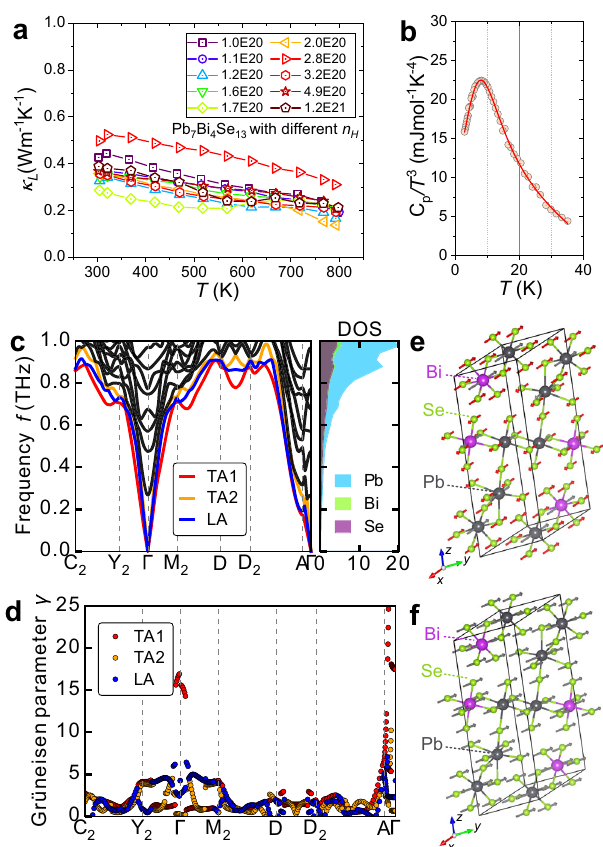
Fig. 5 Lattice thermal conductivity and phonon-related calculations. a Lattice thermal conductivity, κ L . b T dependence of C p / T 3 . The circle is the experimental data and the line is established by using a Debye and three Einstein modes. c Phonon dispersions and atom-projected phonon DOS of the low-frequency phonons up to f = 1.0 THz. Transverse acoustic phonons, TA1 and TA2 are plotted in red and orange colors. Longitudinal acoustic phonon, LA, is in the blue line. Optical phonons are in black lines. In the low-frequency region, the dominant contribution stems from Pb atoms. d Grüneisen dispersions. Displacement patterns of e the low-frequency optical phonon at Γ point, and f low-frequency TA1 mode at Γ